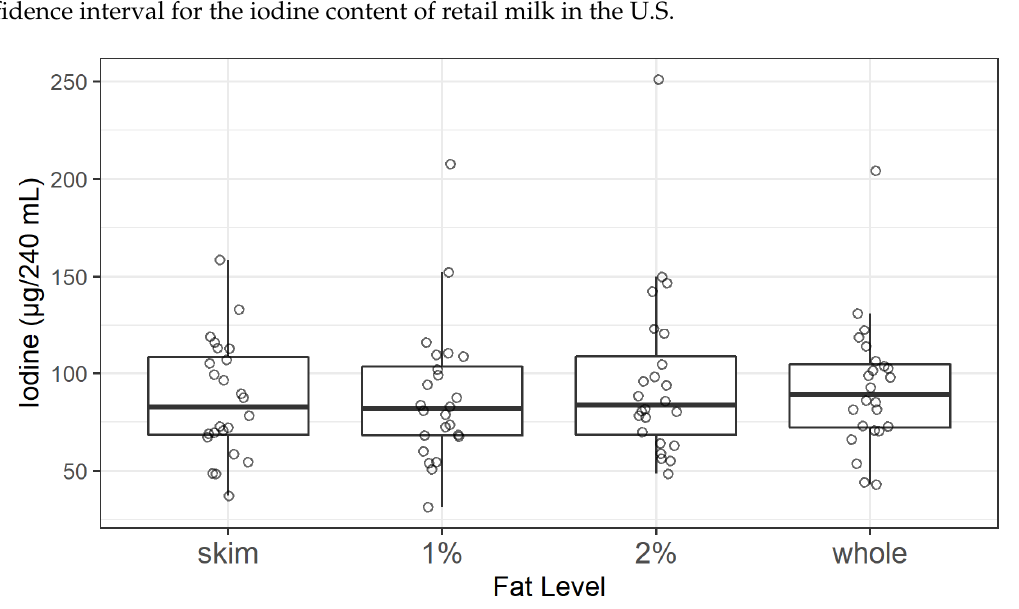
Figure 2. Iodine content of U.S. retail milk samples by fat level. Median of each milkfat type is depicted with heavy horizontal line, showing no statistically significant difference between milkfat levels.